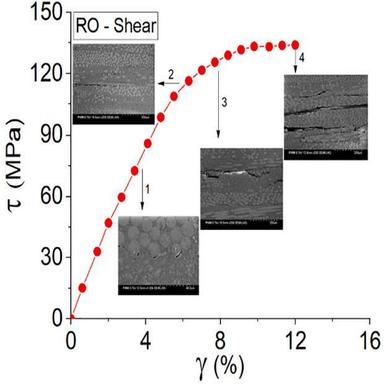
Quasi-static shear test of RO-A-SMC composite coupled to the microstructure observation; (1) fiber/matrix debonding, (2), (3) crack propagation and (4) pseudo-delamination.